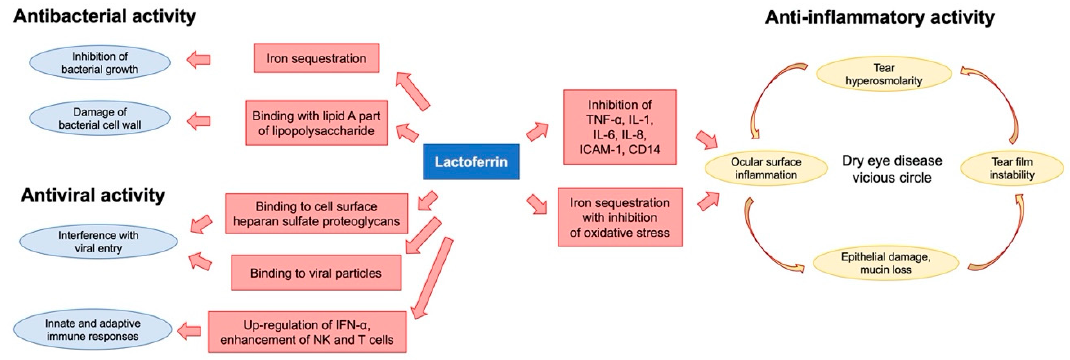
Figure 1. Flowchart showing the mechanisms of action of lactoferrin in ocular diseases. Iron sequestration is the basis of the bacteriostatic effect of lactoferrin. The molecule also has a direct bactericidal activity thanks to its binding with lipid A domains of the bacterial lipopolysaccharide. The binding to viral surface components as well as to heparansulfate proteoglycans inhibits the virus–host cell interaction and is responsible for the antiviral activity. Moreover, lactoferrin regulates innate and adaptive immune responses against infections. The effects of lactoferrin on the vicious circle of dry eye disease are related to the downregulation of numerous pro-inflammatory cytokines as well as to the anti-oxidative activity.